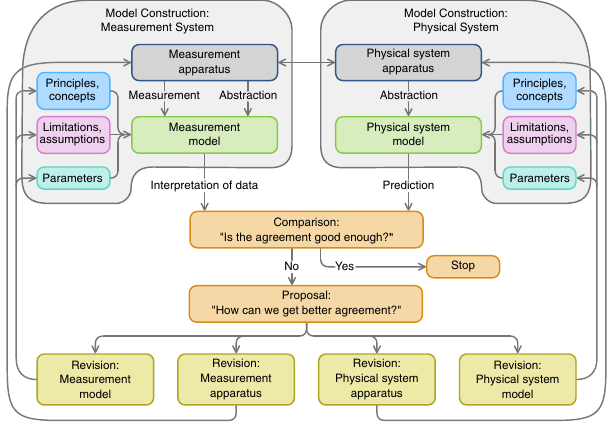
FIG. 1. Diagram of the Modeling Framework for Experimental